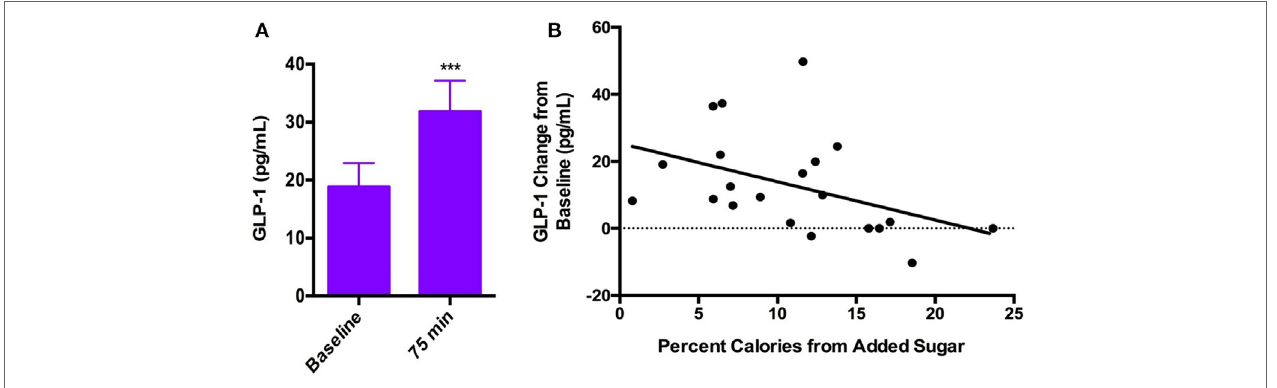
FigUre 3 | (a) Systemic GLP-1 increased significantly after consumption of oral glucose (Baseline = 18.8 ± 18.9 pg/ml; 75 min = 31.8 ± 24.5 pg/ml; p < 0.001). (b) Negative correlation between GLP-1 response to oral glucose and percent calories consumed from added sugar ( r s = − 0.50, p =